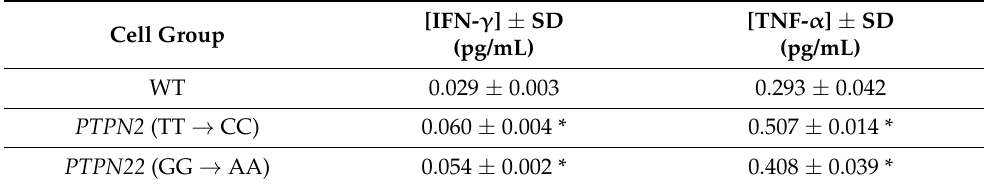
Figure 4. Effect of PTPN2/22 SNPs on CD25 (IL-2RA) Expression in CRISPR-Cas9-edited Jurkat T-cells Stimulated with PHA. Total nuclei are stained with DAPI in blue ( A – C ). CD25 positive cells are stained in green ( D – F ), and merged cells are presented with blue and green ( G – L ). The histogram ( B ) shows percentage of cells expressing CD25 in each group (WT, PTPN2 SNP, and PTPN22 SNP Jurkat T-cells). ( n = 3). * p -value < 0.05. Table 4. Effect of PTPN2/22 SNPs on IFN- γ and TNF- α Secretion in CRISPR-Cas9-edited Jurkat T-cells Stimulated with